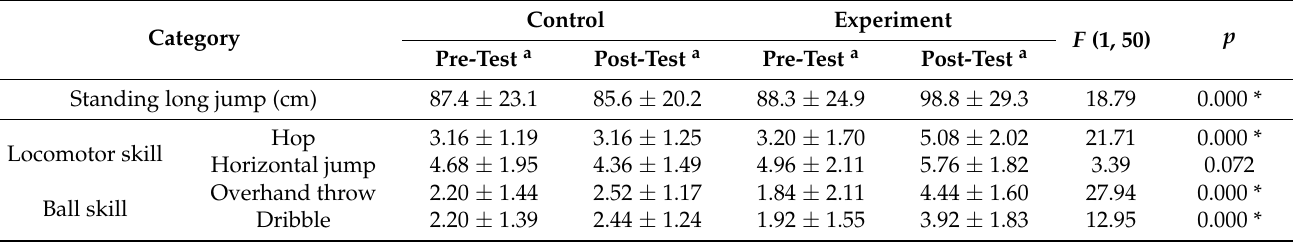
Table 3. Descriptive and statistical results in physical fitness and fundamental motor skills between pre- and post-test of the groups.